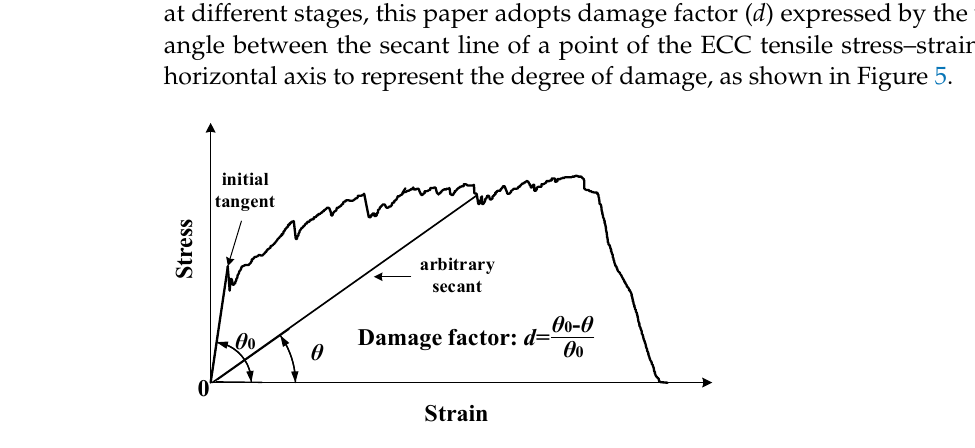
Therefore, the damage factor can be expressed as: